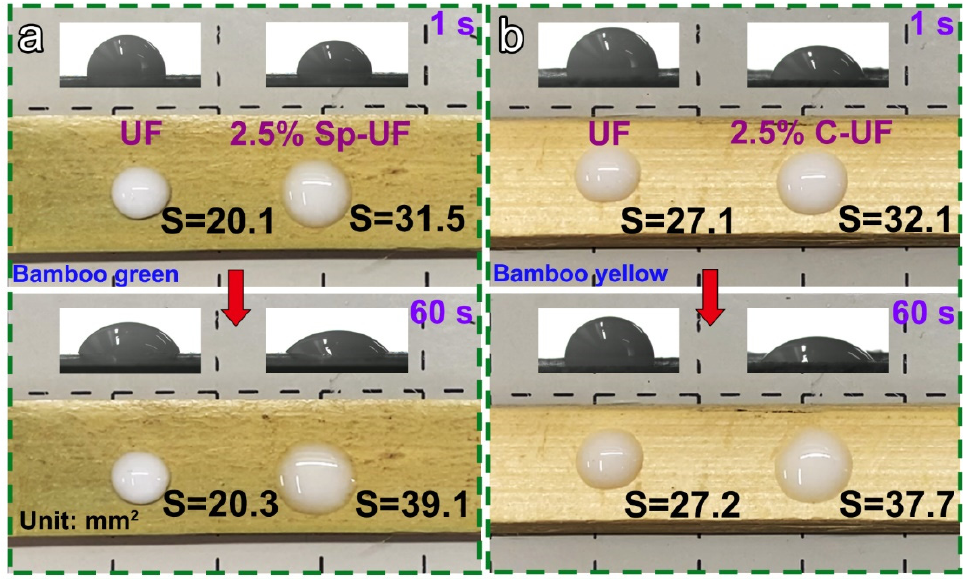
Figure 4. Optical photos and corresponding CA images of UF and reconfigured UF resins in contact with the surface of ( a ) bamboo green and ( b ) bamboo yellow for 1 s and 60 s.